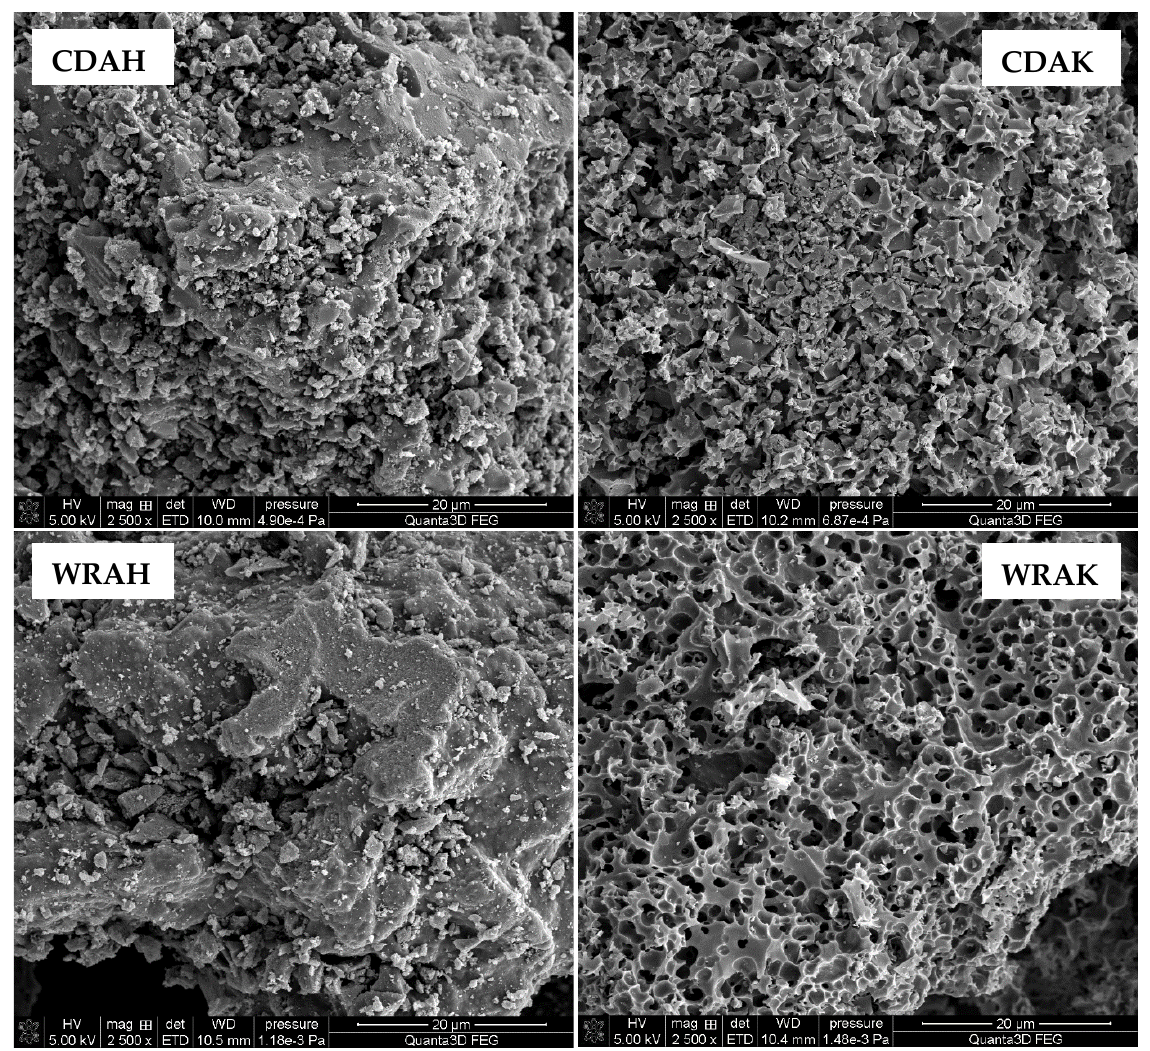
Figure 3. SEM images of the selected samples activated with H 3 PO 4 and K 2 CO 3 .